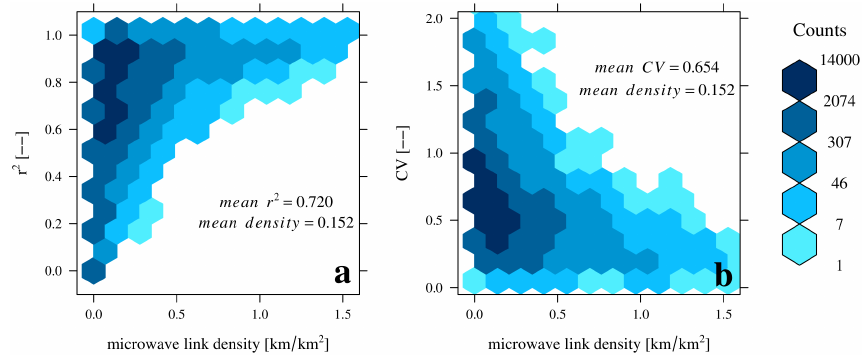
Figure 6. Scatter density plots of coefficient of determination ( r 2 ) and coefficient of variation (CV) vs. microwave link density (averaged over 155km 2 ), for the fullSIM case at 15min and 1km 2 spatial scale. The colour scale is